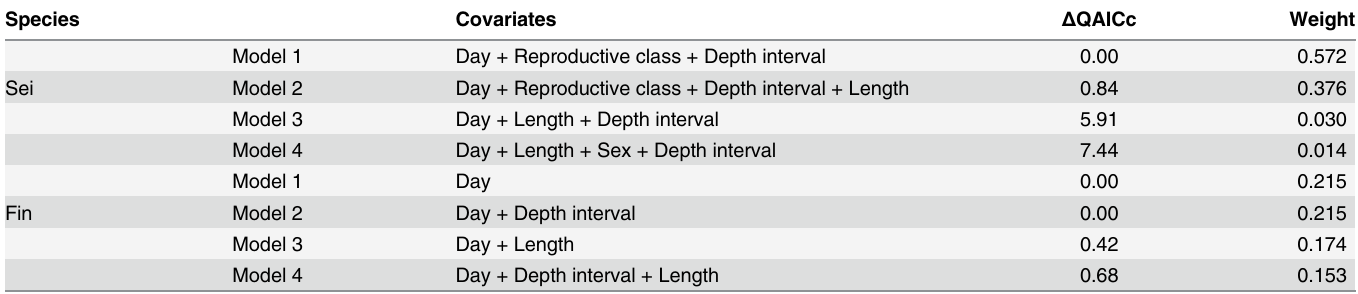
Table 5. Candidate models for the proportion of unhealed bites that were recent in all whale